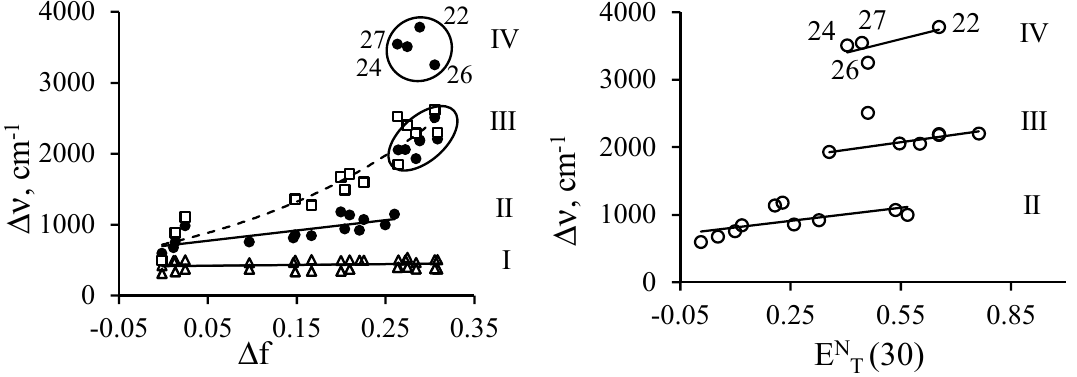
Figure 21. The dependencies of the Stokes shift ( Δν ) on Lippert-Mataga ( ∆ f = f ( ε ) − f (n 2 )) and E NT (30) parameters for BODIPY- Schiff dye (curves II, III and scatterplot IV; black circles) and dyes VIII – IX (empty triangles and squares, curves I and III). The dependencies for solutions with a dielectric permittivity ε < 17.8 (I and II); ε > 17.8 (III); and DMSO, DMF (dimethylformamide), C 2 H 5 OH, + KOH (IV). Reprinted with permission from Ref. [87]. Copyright 2015, The American Chemical Society.